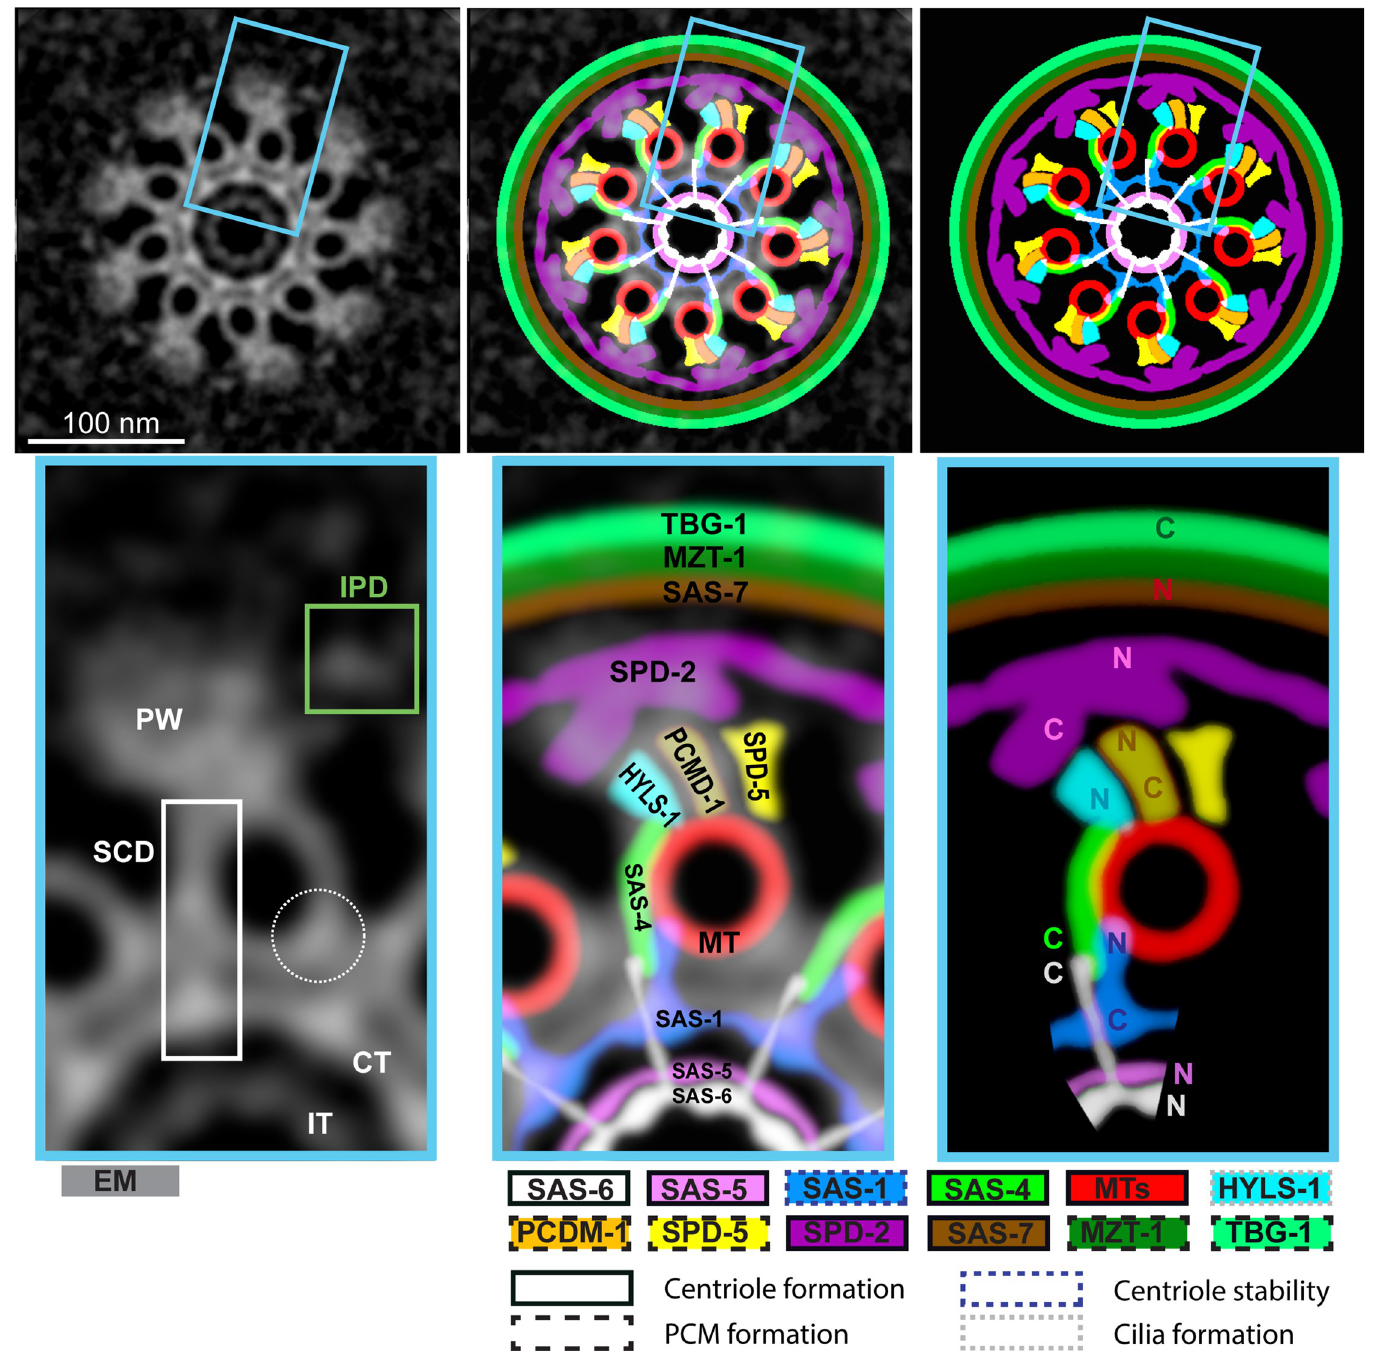
Fig 7. Schematic representation of the localization of components within the centriole. (Top left) 9-fold symmetrized EM image of a centriole. (Top middle) Overlay of the image on the left with corresponding schematic representation on the right. (Top right) Coarse grained schematic representation of the localization within the centriole of components analyzed in this study. (Bottom left) Magnification of the blue boxed region from the image above. Green box highlights the IPD, white box the SCD. Dashed circle highlights a small density to which no known centriolar protein has been assigned (see Discussion). (Bottom middle and right) Magnifications of the blue boxed regions from the images above, with an indication of the localization of each protein, including where the N- and C-terminus maps when known. No mention of termini is indicated when merely antibodies were utilized. EM, electron microscopy; IPD, Inter Paddlewheel Density; SCD, SAS-6/4/1 Containing Density.